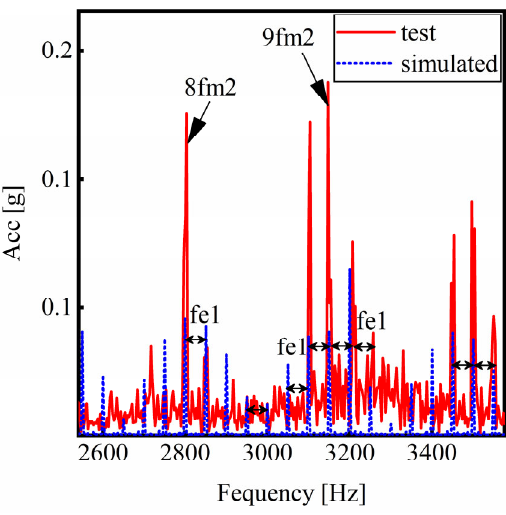
Figure 15. The zoomed plot of Figure 14.